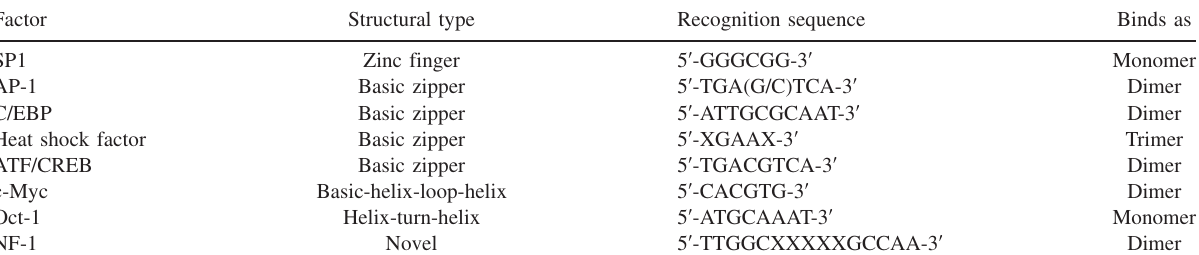
Table 5 Examples of some transcription factors and their recognized DNA